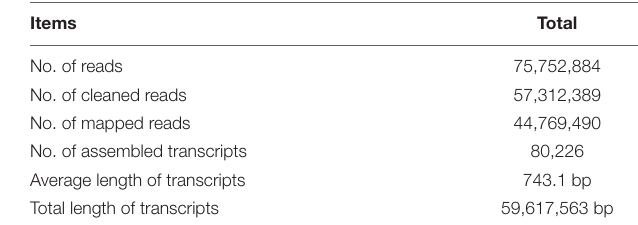
TABLE 1 | Summary of rose petal abscission zone transcriptome sequencing